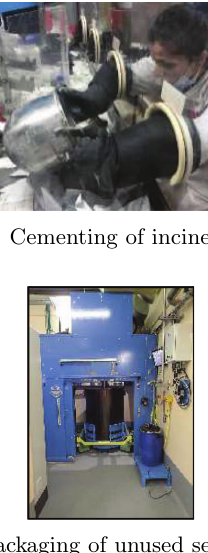
Fig. 21. Packaging of unused sealed